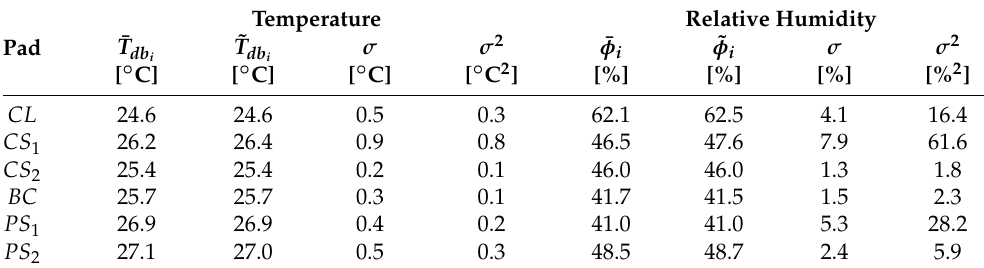
Table 3. Statistical descriptions of the inlet air dry-bulb temperature ( T db for the wind tunnel tests. ¯ T db deviation and σ 2 is the